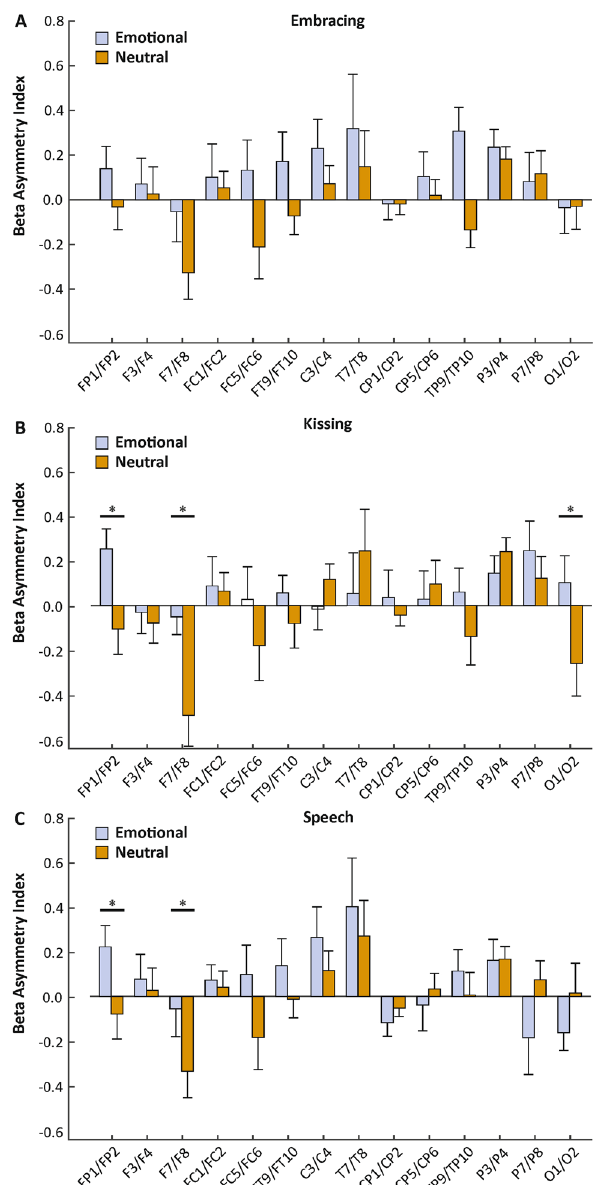
Figure 4. Electrode-specific analysis of beta power asymmetries during the three behavioral tasks ( A : Embracing, B : Kissing, C : Speech) in the emotional and neutral conditions. Error bars represent